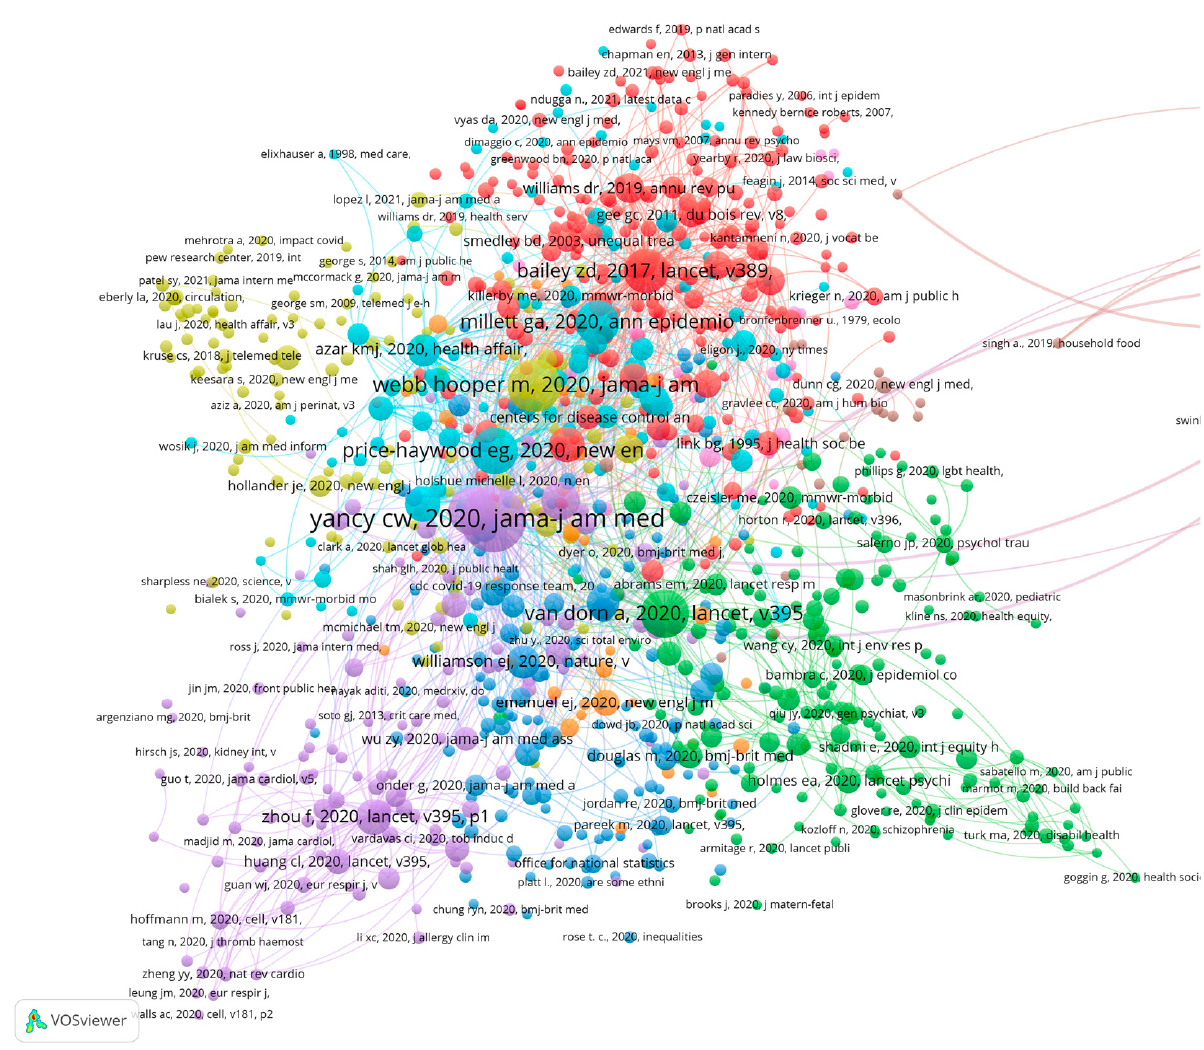
Figure 9. Co-citation network of cited references.